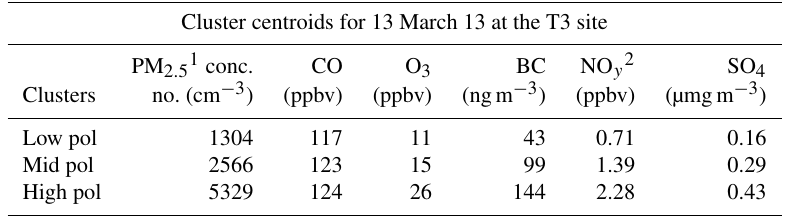
Table 2. Cluster centroids used to analyze clean and polluted conditions. Note: ppbv – parts per billion by volume.